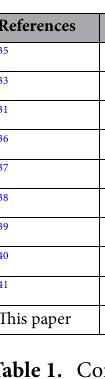
Table 1. Comparison of FOM and Q value of the proposed device with the previously reported terahertz MMA.